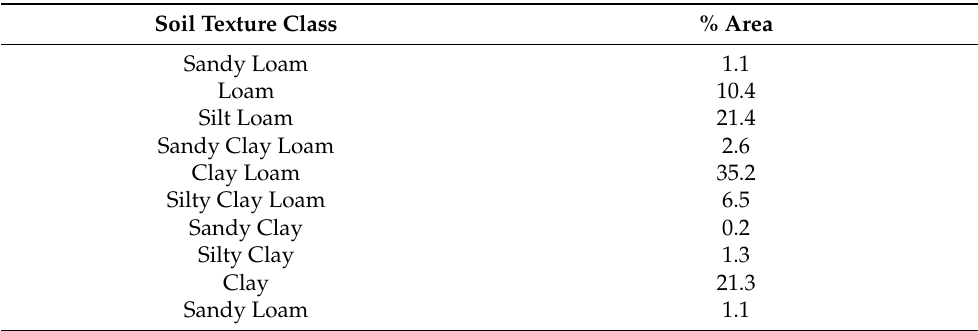
Table 2. Areal percentage coverage of soil types of the Almyros basin according to the U.S. Depart- ment of Agriculture (U.S.D.A.) classification.